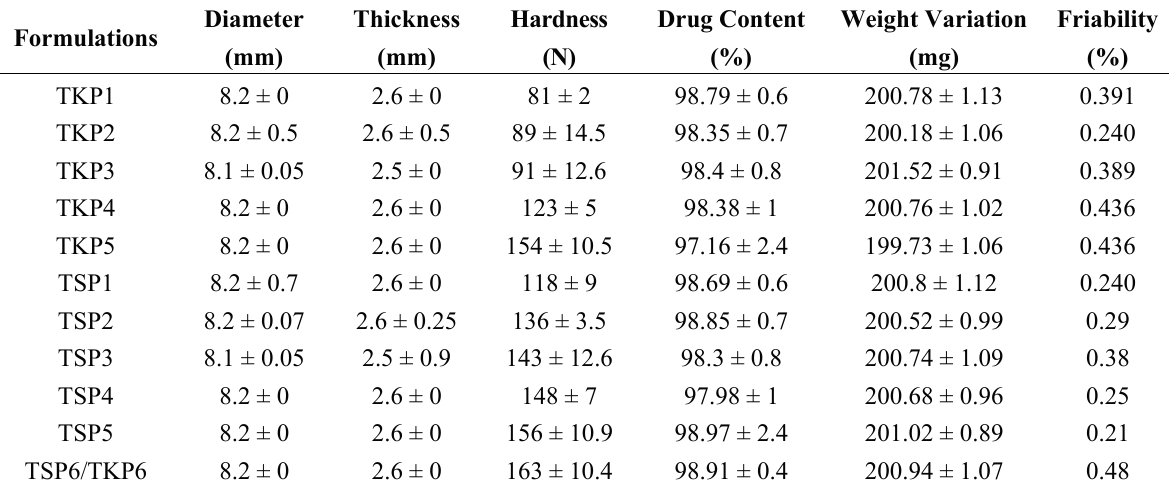
Table 2. Physical evaluation of prepared famotidine matrix